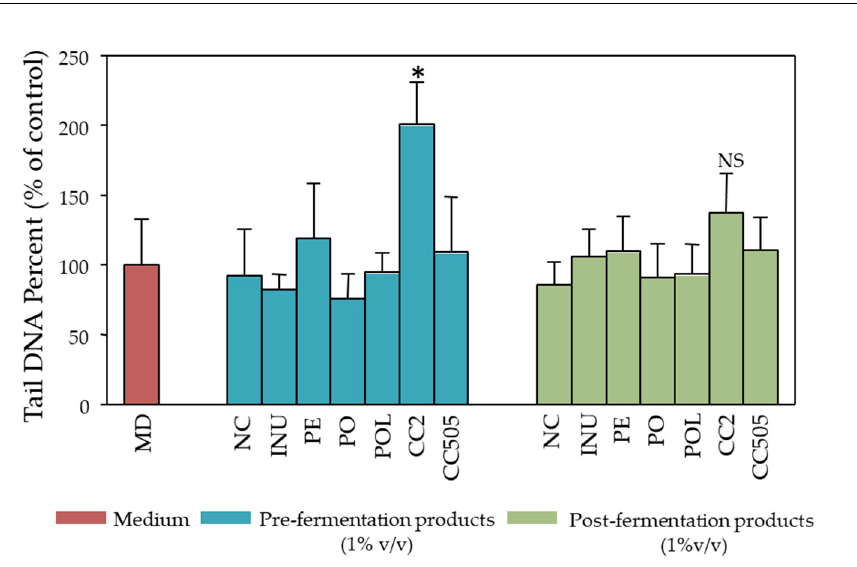
Figure 6. Direct genotoxic e ff ects of pre- and post-fermentation samples: Caco-2 cells were treated with 1% v / v pre- and post-fermentation samples of NC, INU, PO, POL, PE, CC2 and CC505. Cells treated with culture medium only served as control (MD). NC: basal medium with no additional carbohydrate source, INU: inulin, PO: P. ostreatus strain 1123, POL: P. ostreatus strain LGM 22, PE: P. eryngii strain LGAM 216, CC2: C. cylindracea strain CC2, CC505: C. cylindracea strain CC505. All values are expressed as the mean ± SD of two independent experiments. * p < 0.05 versus medium. Pooled samples from 8 donors were used. Associations were not significant unless otherwise indicated.